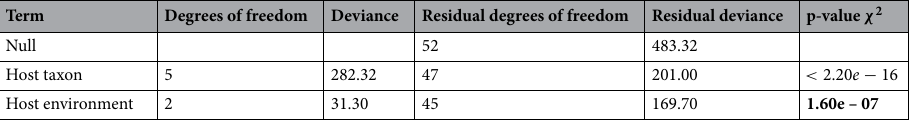
Table 2. Analysis of deviance for GLM (Richness microbiome compositional alpha diversity. Significant values are in bold.